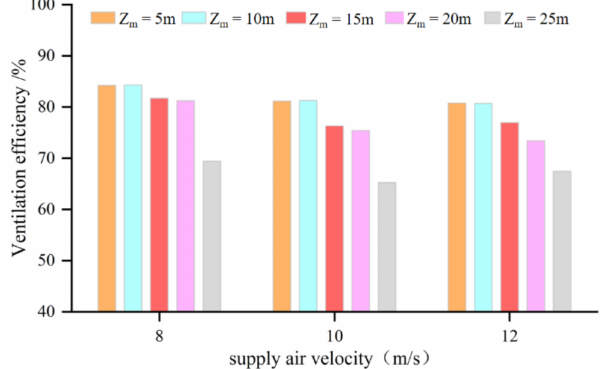
Figure 14. Comparisons of VE at different supply air velocities with respect to Z m .